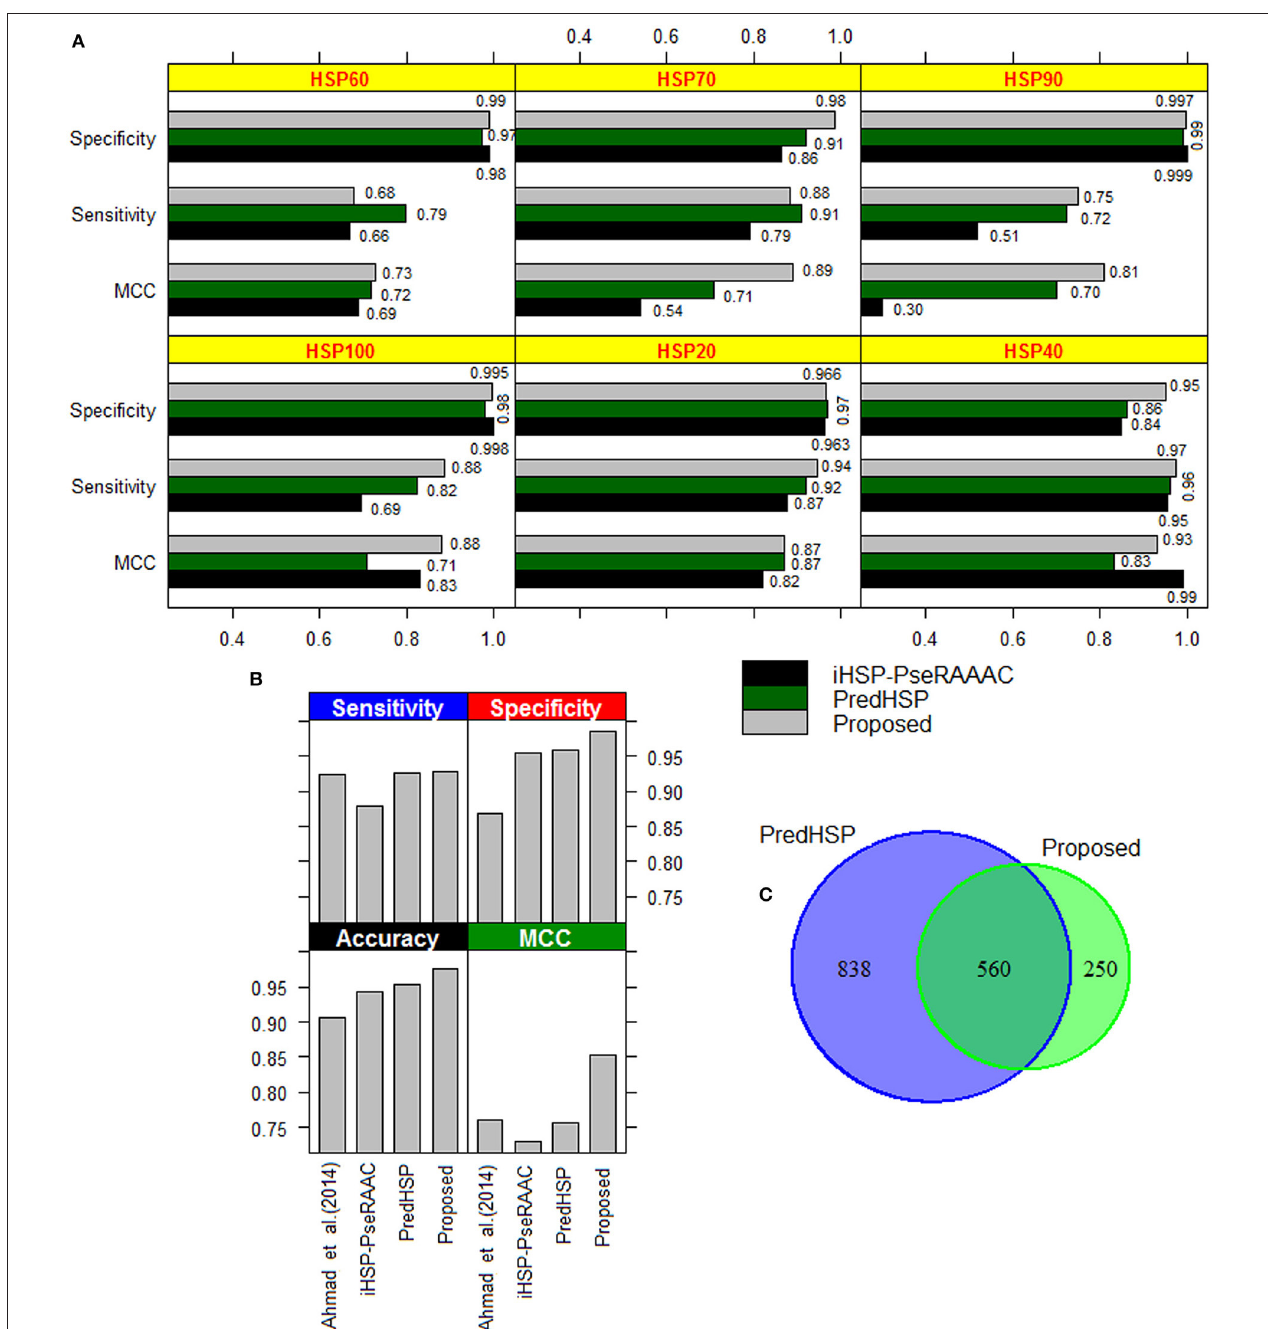
FIGURE 3 | (A) Bar diagrams of performance metrics for the proposed approach, PredHSP and iHSP-PseRAAAC with respect to classification of different families of HSPs. With some exceptions (sensitivity in HSP60 and HSP70; MCC in HSP40), proposed approach is seen to achieve higher accuracy than that of other two approaches. (B) Bar diagrams of weighted accuracies for the above mentioned three approaches along with the Ahmad et al. (2015) approach. It can be seen that the weighted accuracies are higher for the proposed approach followed by PredHSP. (C) Venn diagram showing the number of HSPs predicted common (i.e., 560) to the proposed approach and PredHSP, for the negative dataset of 5,000 protein sequences.